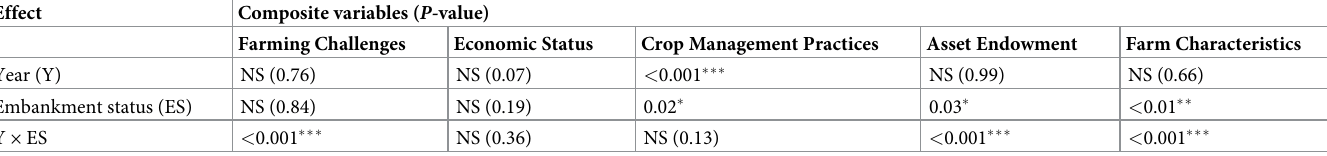
Table 3. Multi-level model summary showing the effects of year and embankment status on each factor (latent